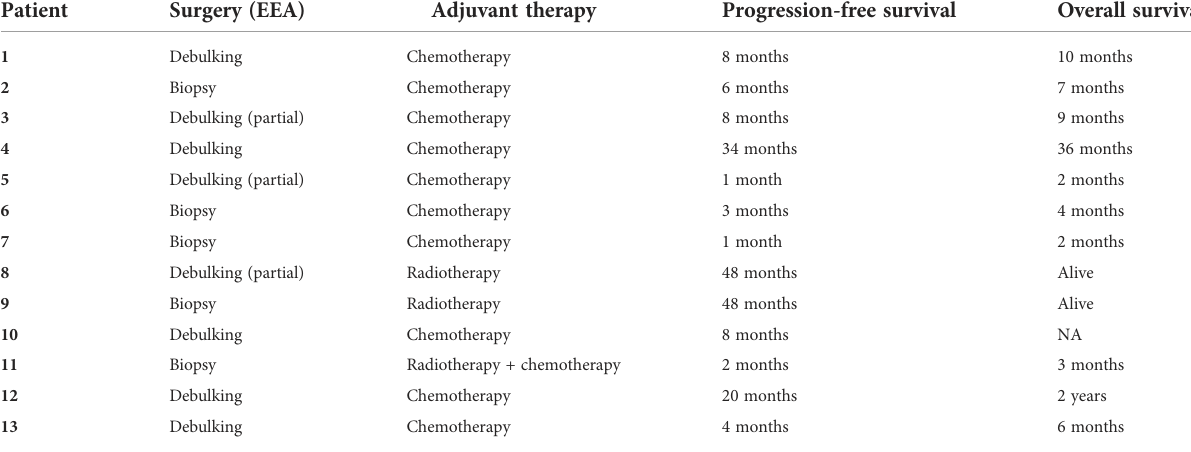
TABLE 4 Surgical and adjuvant